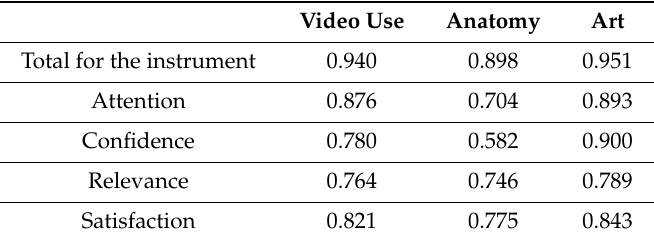
Table2. ReliabilityindexcorrespondingtotheInstructionalMaterialMotivationalSurvey(IMMS)instrument.